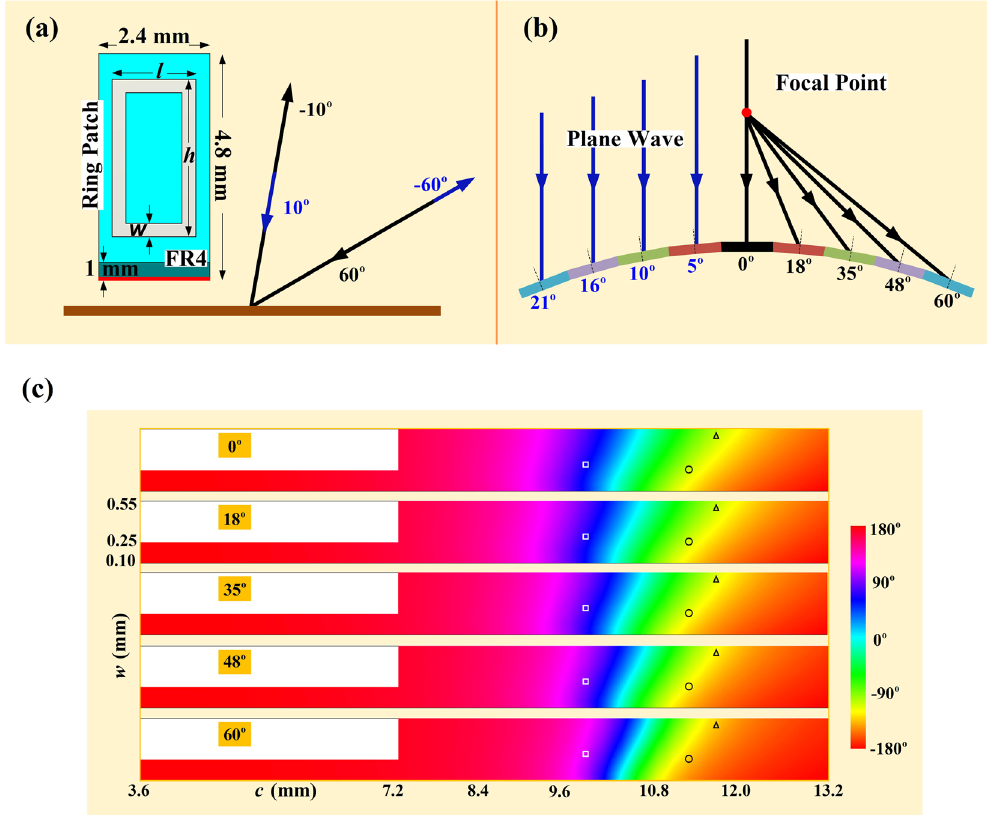
Figure 3. Practical implementation of the negative reflecting meta-mirrors using rectangular ring patches on the FR4 grounded slab. ( a ) Unit cell of the ring patch for the planar meta-mirror design. ( b ) Simplified structure with nine discrete polygonal surfaces for the convex meta-mirror with the structural merits of symmetry. ( c ) The relationships between the reflecting phases and the ring patches with different structural parameters when considering the incident angles. The square, ring and triangle marks refer to the ring patches having the size of ( c , w ) = (9.84 mm, 0.30 mm), (11.28 mm, 0.25 mm), and (11.76 mm, 0.50 mm).